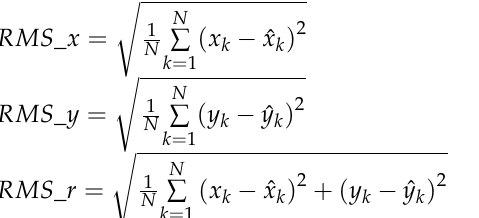
( b ) Figure 5. Simulation conditions. ( a ) The simulated sound velocity profile; ( b ) the floating trajectory of the buoy and the motion trajectory of the underwater mobile node. Figure 6 is the result of the modem position of buoy 1. The blue line with * is the GPS direct measurement result, the red line with o is the real position of the modem of buoy 1, and the yellow belt + line corresponds to the result after the space position calibration of Section 3.1 is performed. It can be seen from Figure 6 that the position of the modem ob- tained after the spatial position calibration is close to the true position while the GPS direct measurement result has a large deviation from the real position of the modem. The corre- sponding root mean square (RMS) values at different coordinates are used to evaluate the performance of the GPS value and the calibrated value: